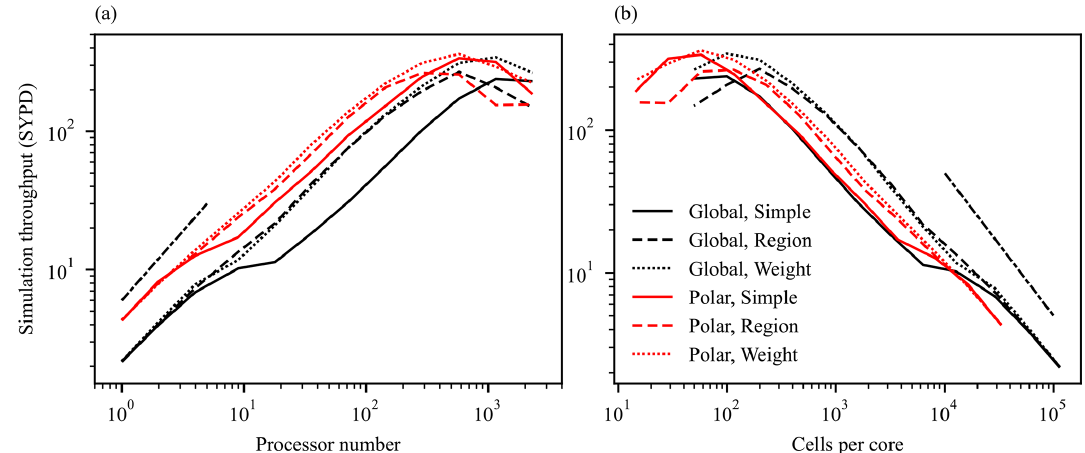
Figure 22. Strong-scaling performance characteristics of MPAS-Seaice for a global QU60km mesh (global) and a QU60km mesh with equatorial cells removed (polar). Simulated years per day of wall clock time (SYPD) is plotted against (a) the number of compute cores and (b) cells per core. Perfect strong scaling would be linear for panel (a) and inversely linear for panel (b) . Three partitioning methods are employed as described in the main text: simple, region, and